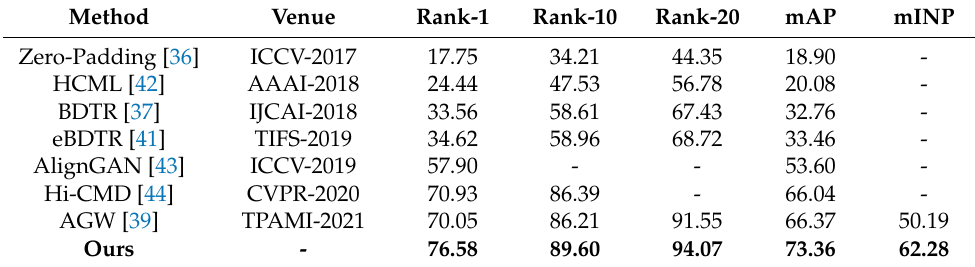
Figure 4. Visual recognition performance of AGW with LoLeG-Net on SYSU-MM01. Table 3. Comparison results in V2I mode for RegDB.